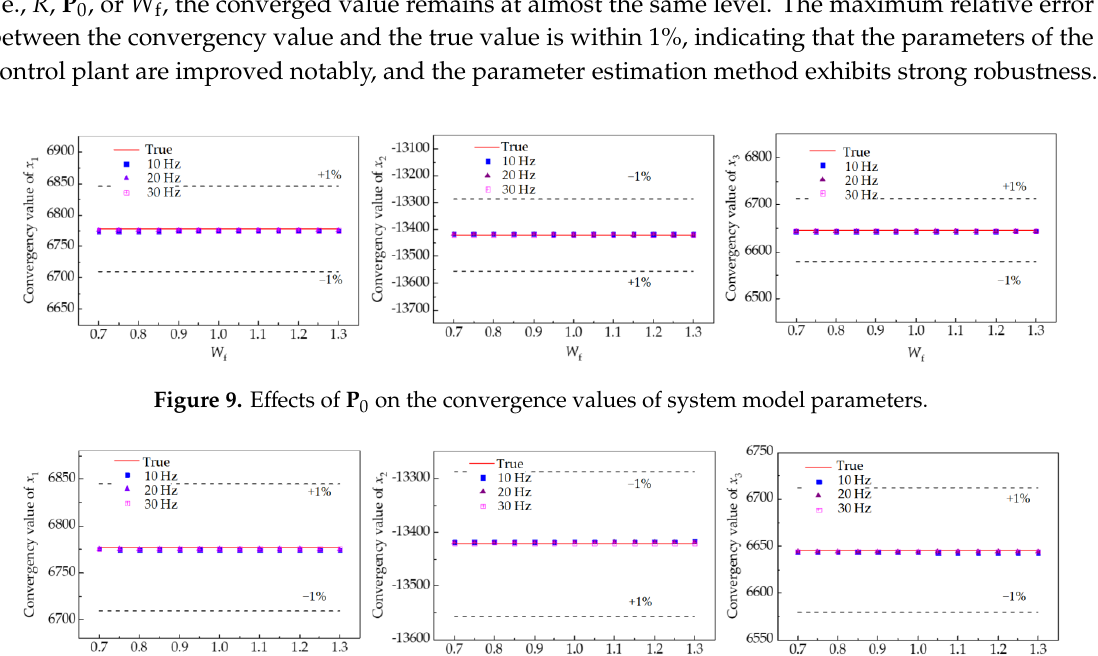
Figure 10. Effects of R on the convergence values of system model parameters.